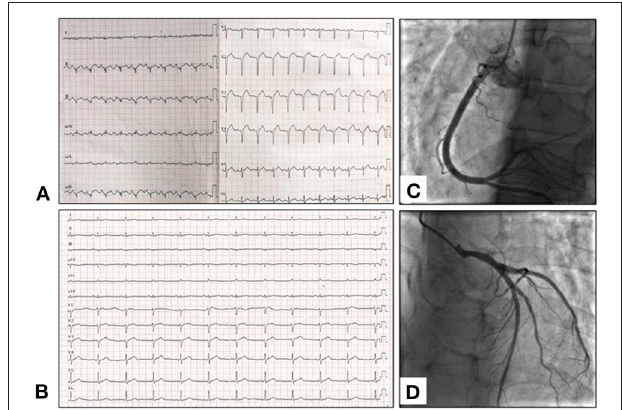
FIGURE 1 | (A) Initial ECG at the emergency room showed poor R wave progression on precordial lead and QS wave on anterior and inferior leads. (B) Follow-up ECG after 3-month therapy showed increased R wave amplitude in inferior leads. (C,D) Coronary angiography demonstrates normal coronary arteries; (C) Right coronary artery. (D) Left coronary